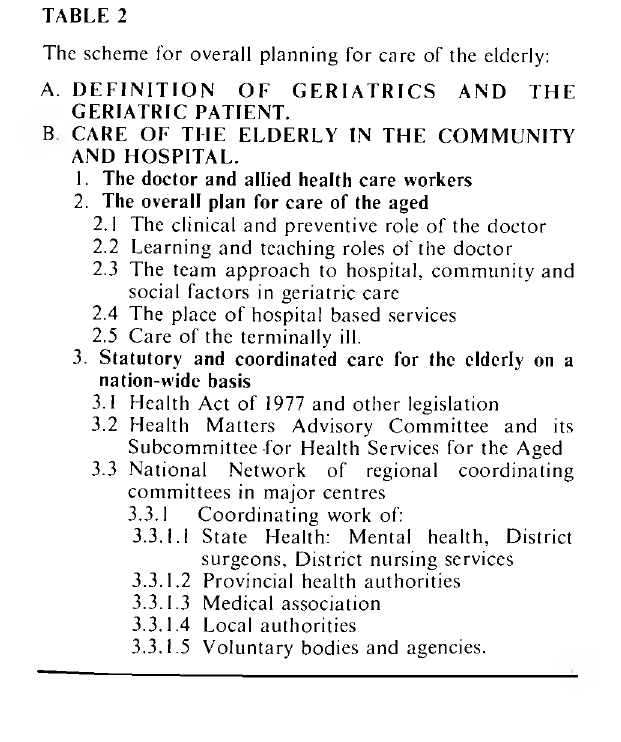
The scheme for overall planning for care of the elderly: